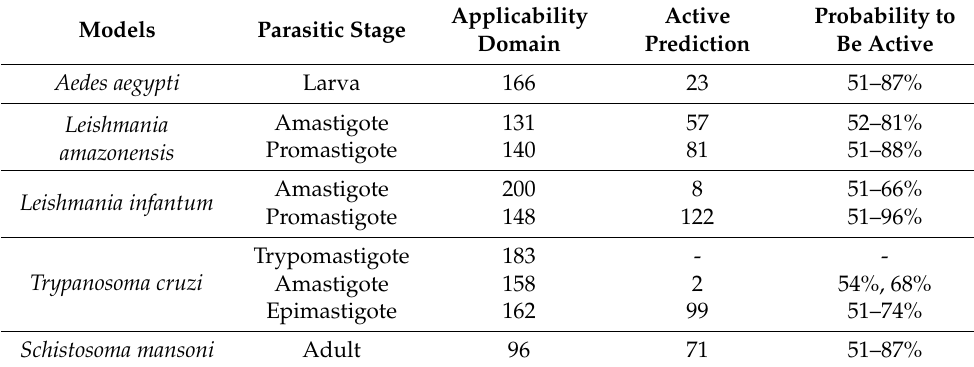
Table 10. Prediction